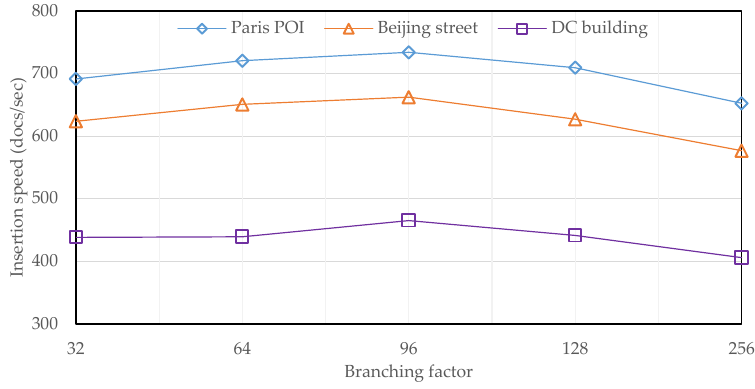
Figure 10. Construction evaluation with varying branching factors.